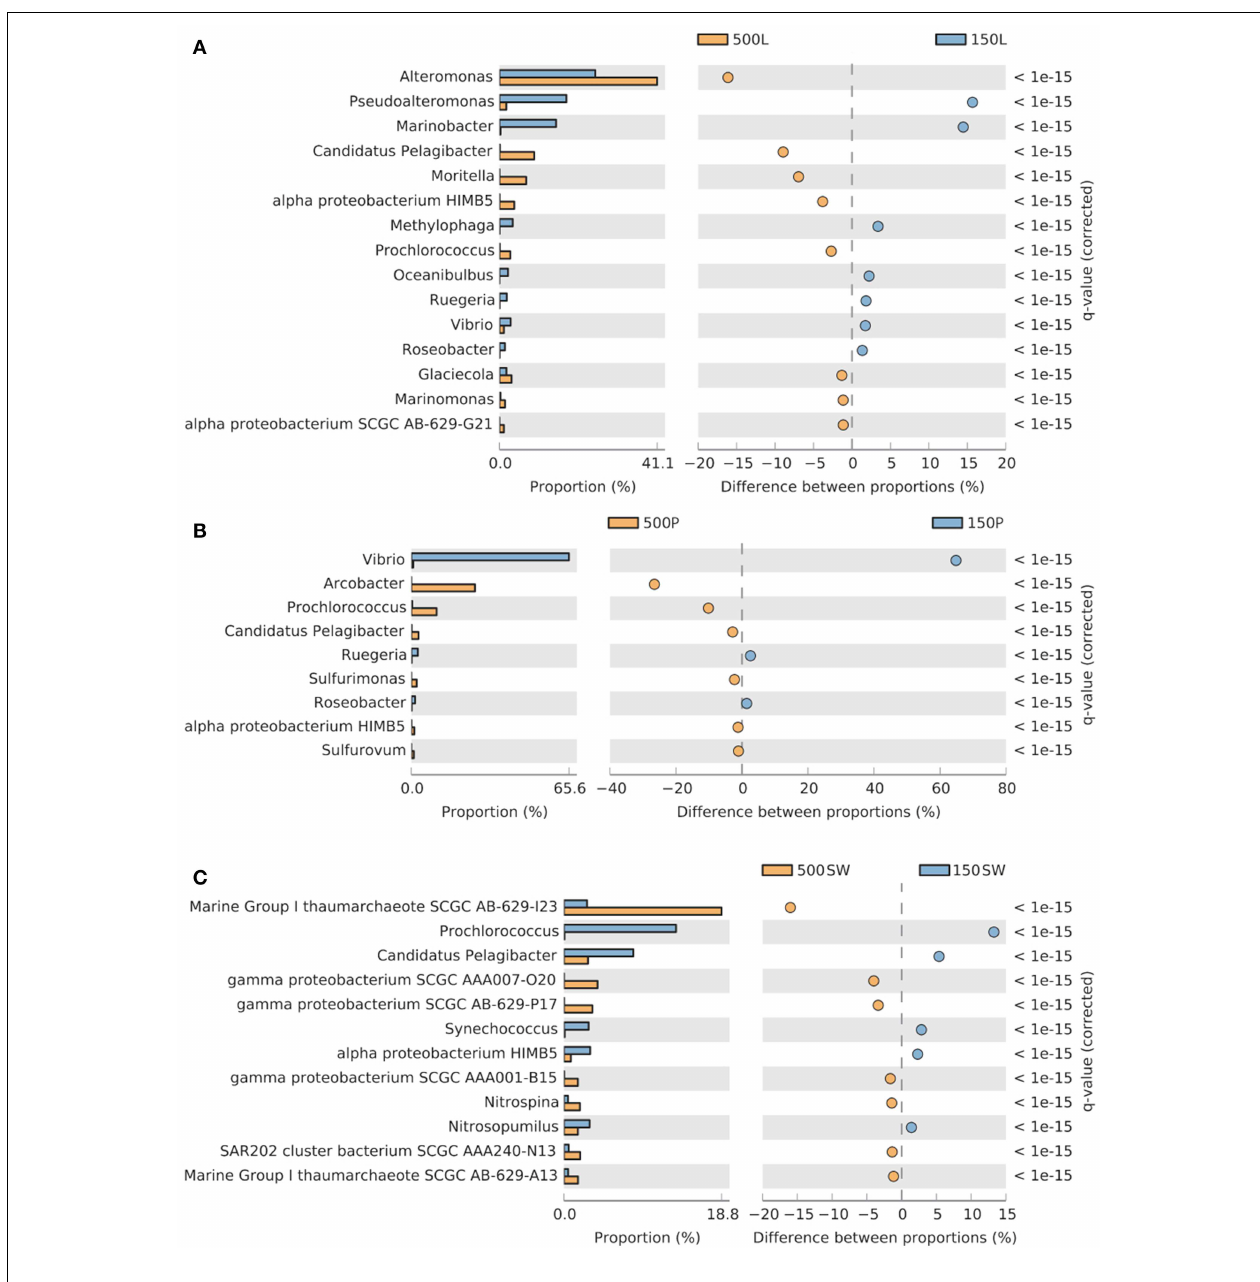
shallow (blue, 150 m) and deep (orange, 500 m) depths with a difference between proportions > 1 are shown. The bar plot displays the mean proportion of sequences assigned to each taxon in each